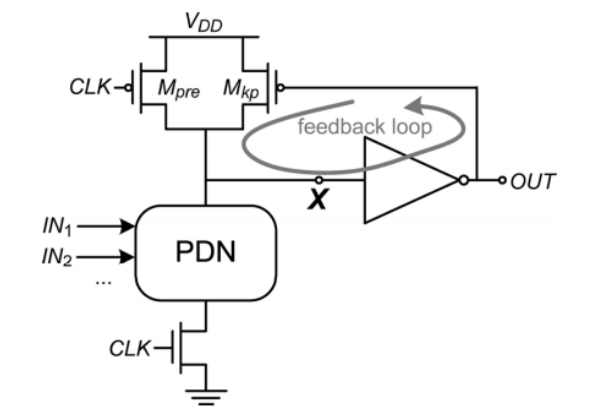
Figure 2. General architecture of Domino Logic